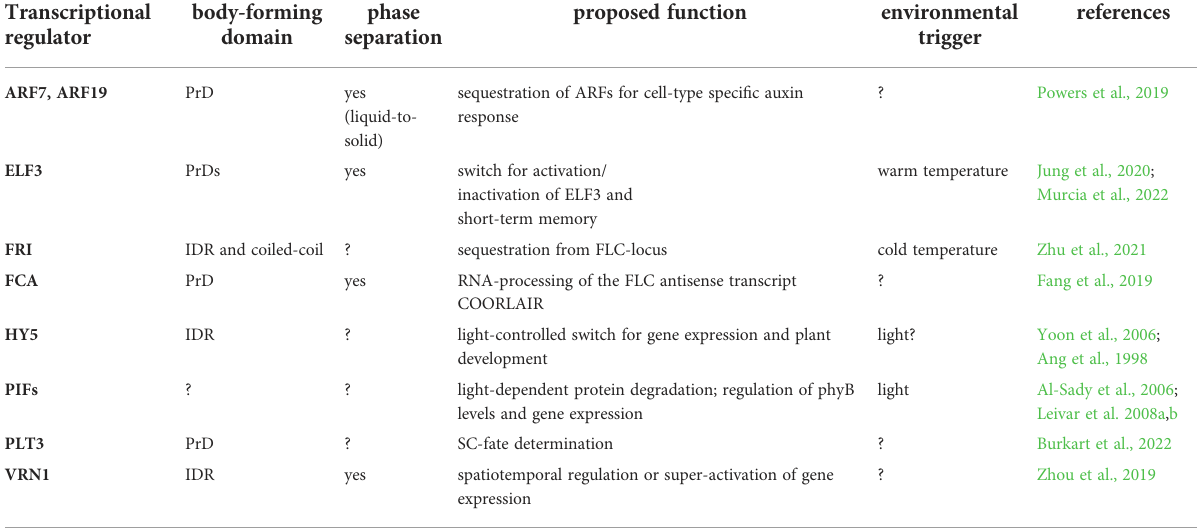
TABLE 1 Body-forming transcriptional regulators in Arabidopsis thaliana